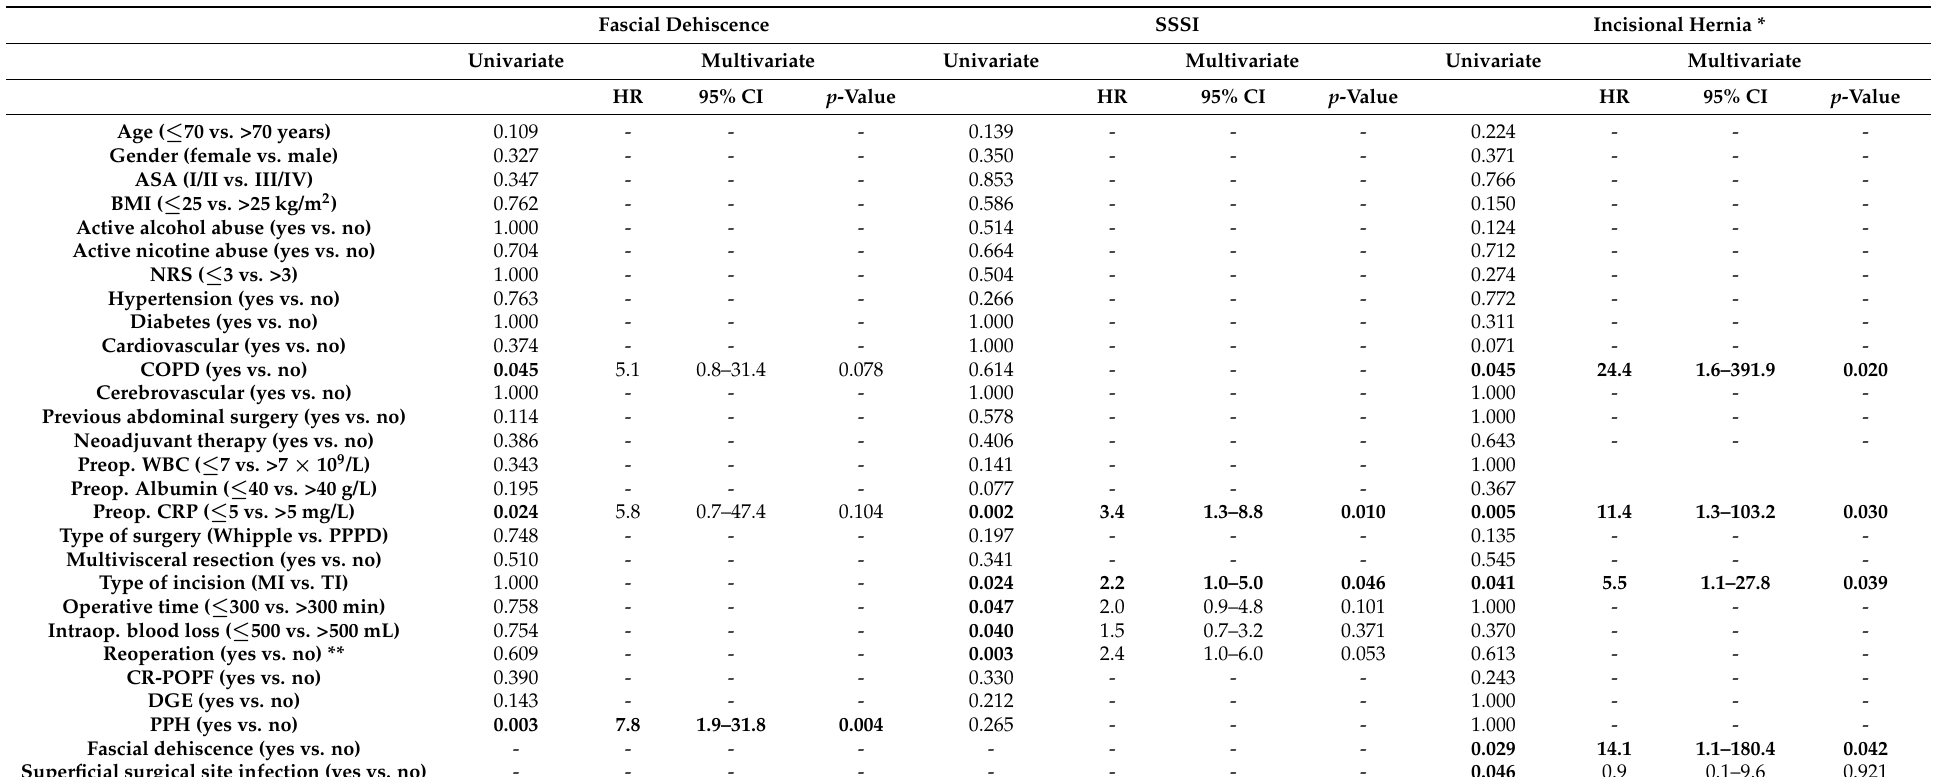
Table 4. Risk factors for postoperative fascial dehiscence, SSI and incisional hernias in patients undergoing pancreatoduodenectomy ( n = 399 and 249, respectively). Fascial Dehiscence SSSI Incisional Hernia * Univariate Multivariate Univariate Multivariate Univariate